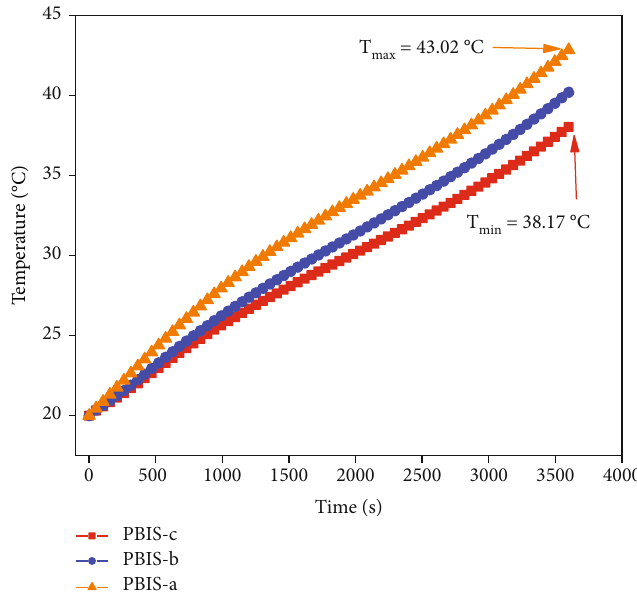
Figure 17: Average temperature rise of the battery in PBIS – a, PBIS – b, and PBIS – c systems after one hour of